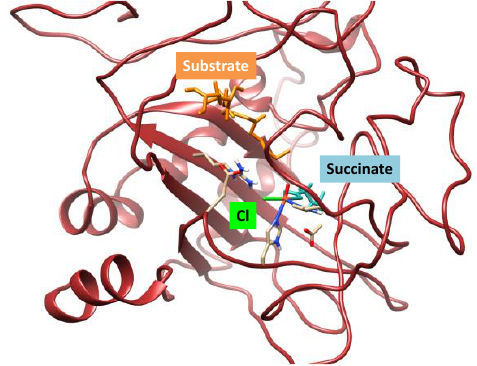
Figure 10. Protein structure of the halogenase domain of HctB with substrate, chloride, and succinate bound. Protein strands in wine-red, chloride in green, succinate in light blue, iron in amber, and oxo group in red.